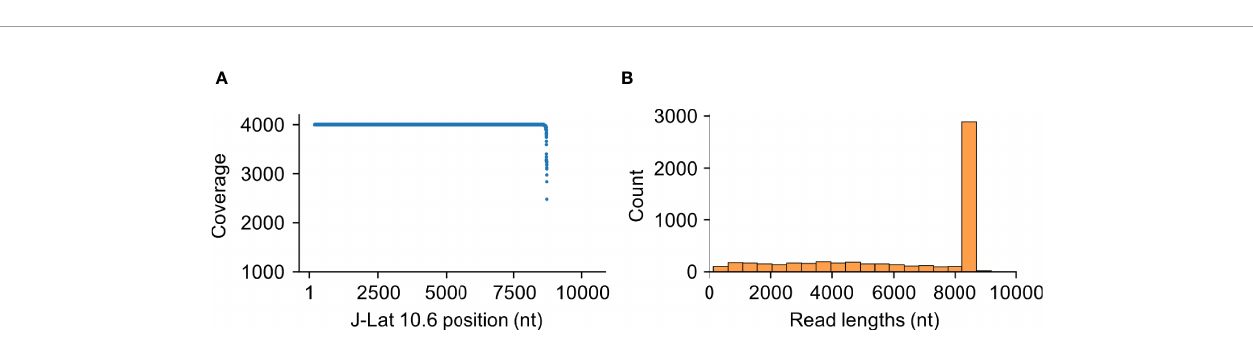
FIGURE 2 | HIV-Quasipore training data comprise long reads and are equally spread across the J-Lat 10.6 genome. (A) Coverage was capped at 4,000 depth and equalized across the J-Lat 10.6 genome. Each point represents a single position within the reference genome. (B) Training data reads are predominantly within the 8,500 – 9,000 nucleotides range with few short reads equally distributed between 0 and 8,000 nucleotides.